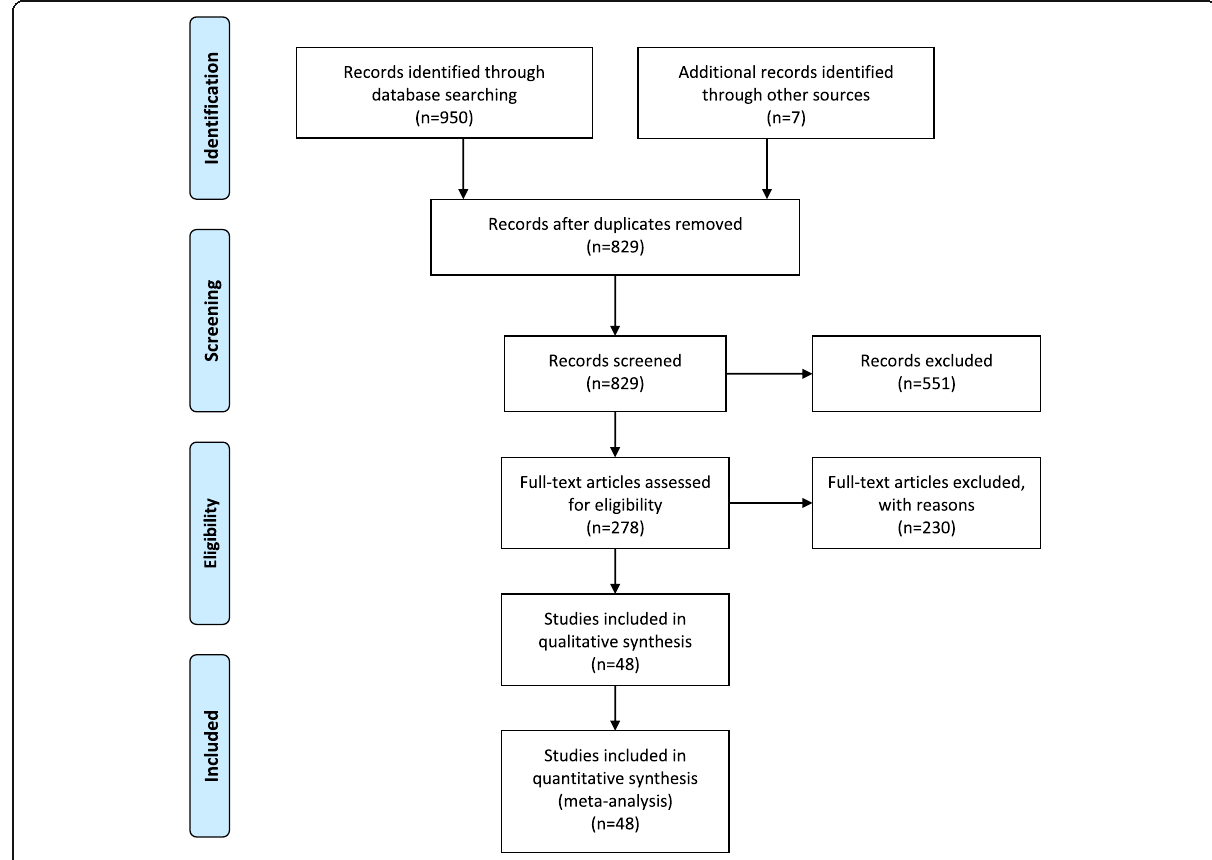
Fig. 1 Flow diagram of the literature search for studies included in